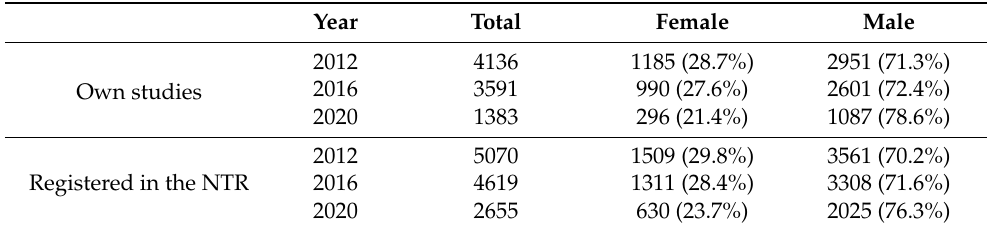
Table 2. Comparison of the number of culture-confirmed tuberculosis cases between the authors’ studies and data from the NTR in Poland in 2012, 2016, and 2020, by sex.